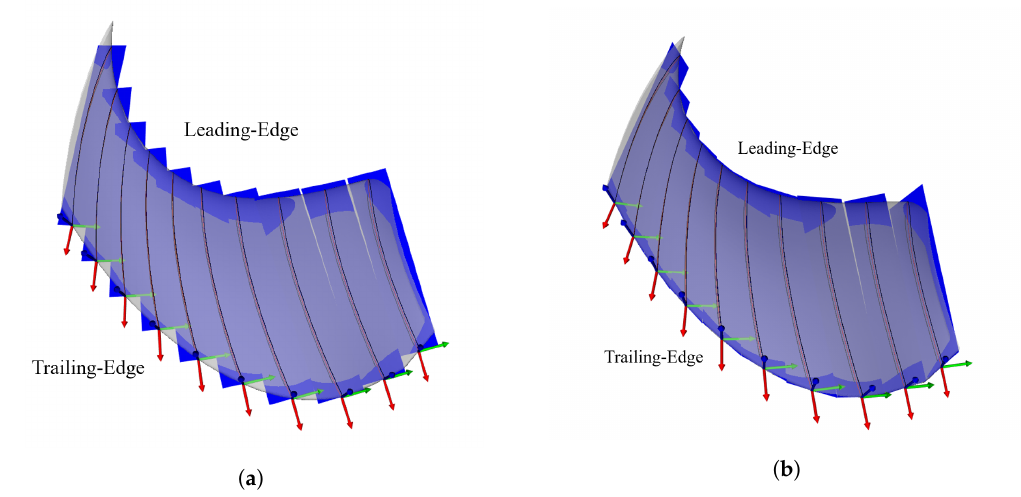
Figure 8. For the trailing-edge case, the blade is divided into 10 segments: in ( a ), a classical unswept trailing-edge formulation can be used; in ( b ), the effect of the sweep is evaluated with blade strips which have locally parallel trailing-edges, following the blade forward-skewed curvature.